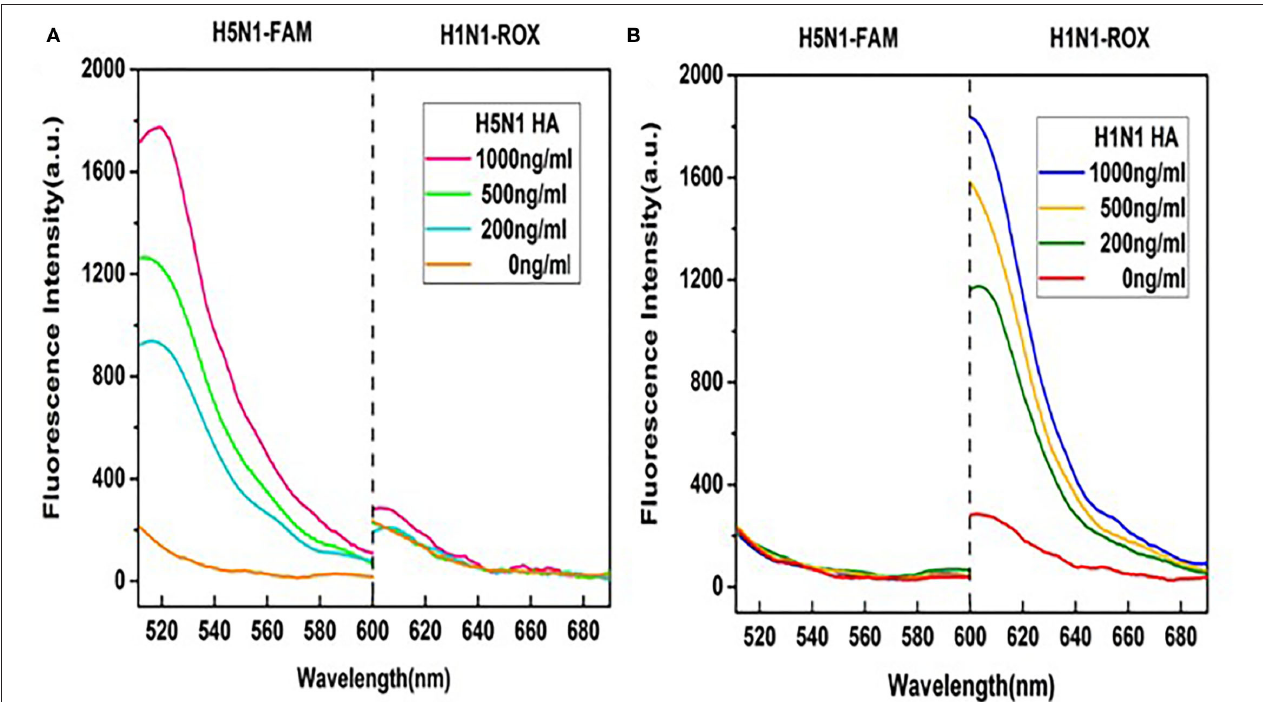
FIGURE 4 | Examination of cross-reactions by monitoring fluorescence spectra of the two probes. (A) Different concentrations of HA of H5N1 in the detection system. (B) Different concentrations of HA of H1N1 in the detection system. A range of HA protein concentrations (0, 200, 500, and 1,000ng/ml) was examined at a fixed GO concentration of 50 µ g/ml.